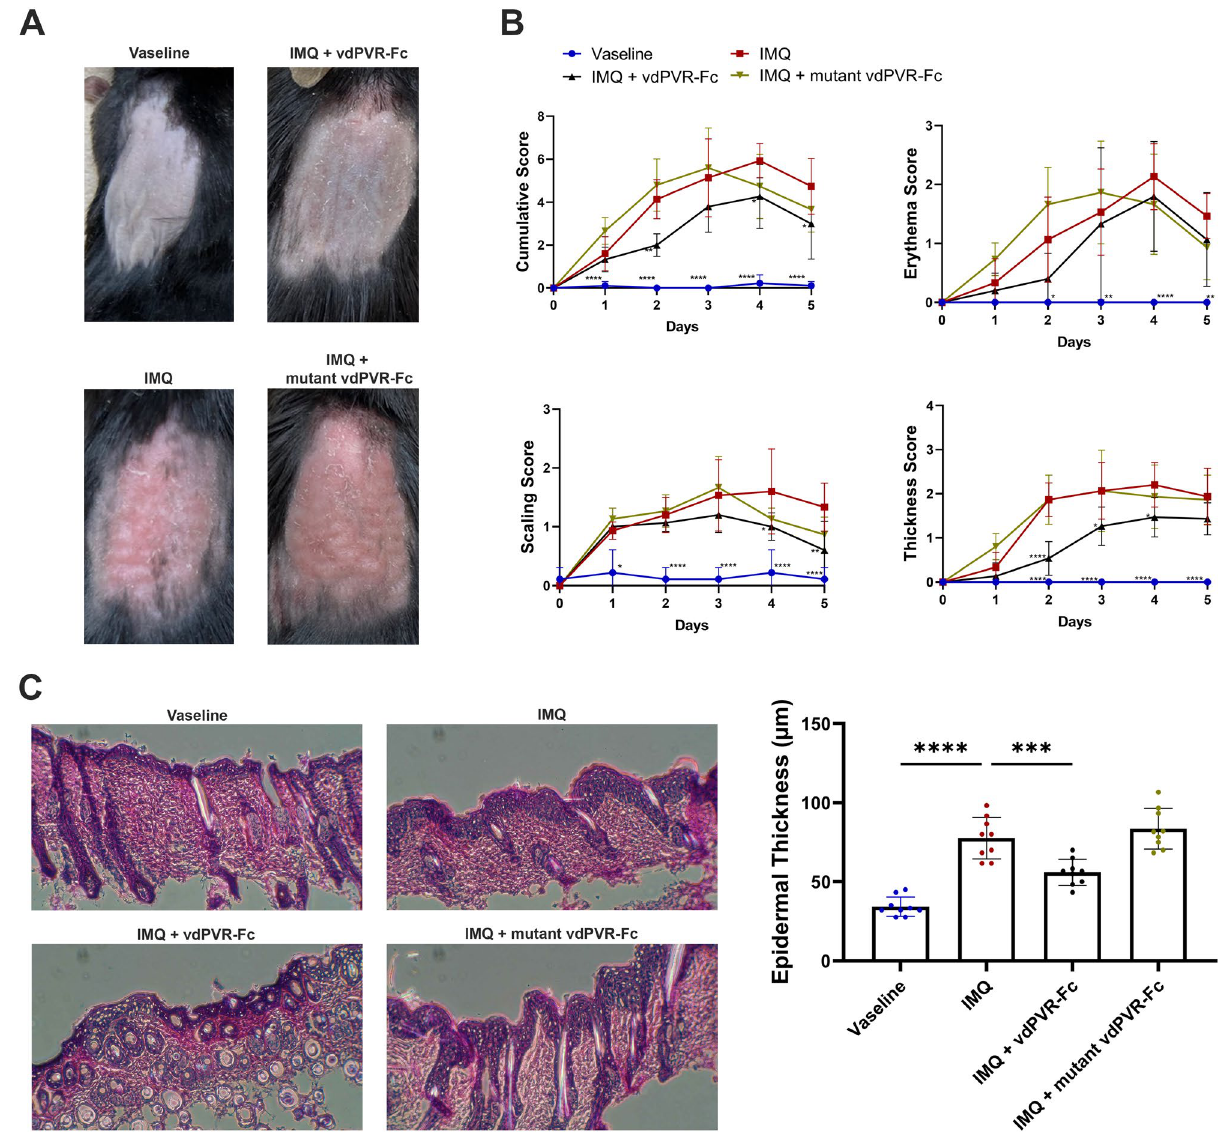
cream on their shaved backs for 5 days. IMQ-treated mice received intraperitoneal doses of either vdPVR-Fc or mutant vdPVR-Fc every other day starting from Day 0. (A) Representative images of mouse back skin on Day 2 after treatment with either Vaseline, imiquimod alone, imiquimod and vdPVR-Fc or imiquimod and mutant vdPVR-Fc. (B) Individual (erythema, scaling, and thickness) and cumulative scores of the treatment groups (n = 5). Graphs show an average score of 3 independent scorers comparing each group to IMQ alone (adjusted p value, evaluated by two-way ANOVA). (C) Hematoxylin and eosin staining of back skin sections of Vaseline, imiquimod alone, vdPVR-Fc and mutant vdPVR-Fc treated mice. Back skin samples were collected on Day 3. Epidermal thickness was quantified from histology sections (n = 9). Error bars represent mean ± SD, *p < 0.05, **p < 0.01 and ****p < 0.0001 relative to IMQ alone group evaluated by